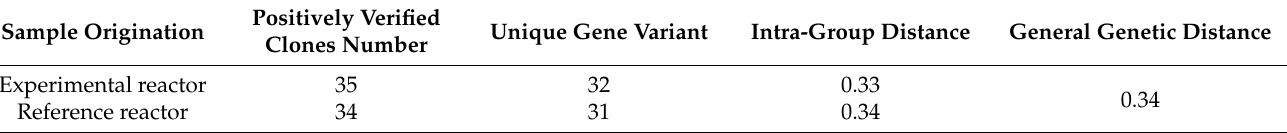
Table 3. Genetic distance values, number of positively verified clones and number of unique sequences within libraries for the nirS